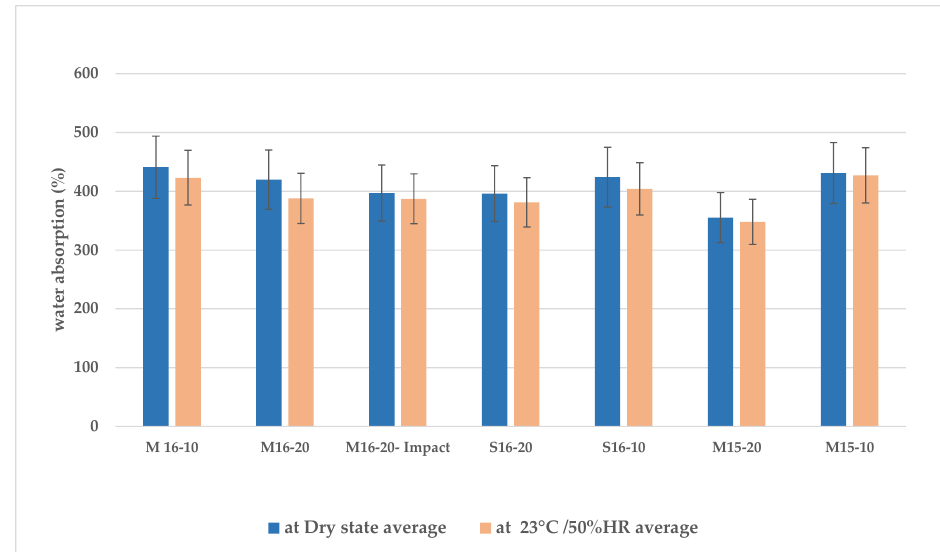
Figure 9. Water absorption of rapeseed straw at 1 h at dry state and 23 °C/50%RH. Due to their high porosity, the amount of water absorbed by plant aggregates gener- ally varies from 200 to 400% of their initial mass. Comparatively, the absorption of wheat straw is in the range of 300 – 330% [56], and that of hemp between 250% and 360% [33,57,58].